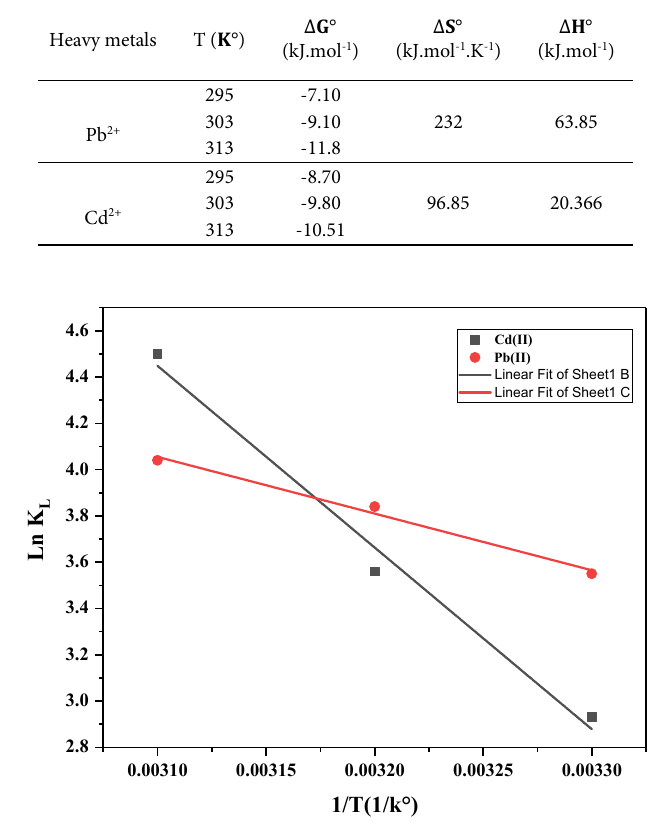
Fig. 13. Van’t Hoff plot for Cd (II) and Pb(II) adsorption on pectin/ γ -Fe